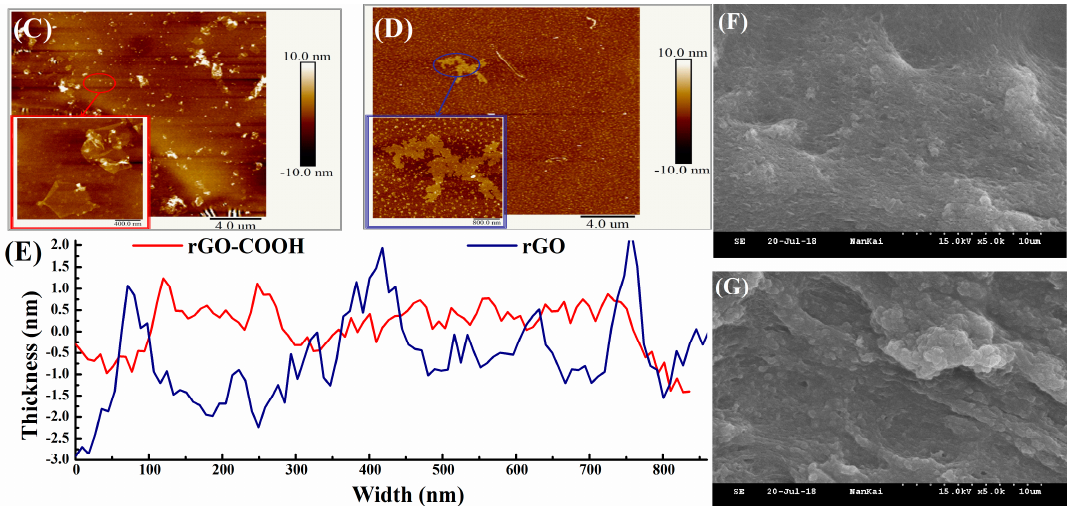
Figure 2. Identification of rGO-COOH. ( A ) Raman spectra of rGO-COOH in comparison with GO-COOH, rGO and GO (excited at λ = 532 nm). ( B ) UV-vis absorbance spectra. ( C , D ) AFM photos of rGO-COOH and rGO films at glass slides. ( E ) AFM analysis for film thickness. ( F , G ) SEM images of rGO-COOH and rGO films, respectively.